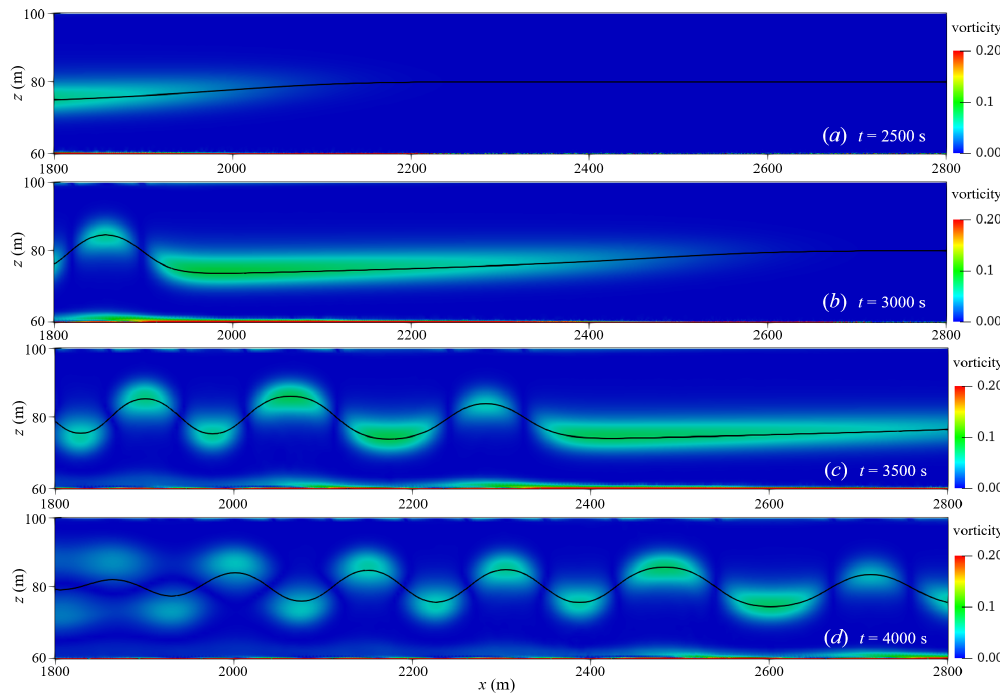
Figure 25. Vorticity field of wave train in shallow water (the black solid line is the